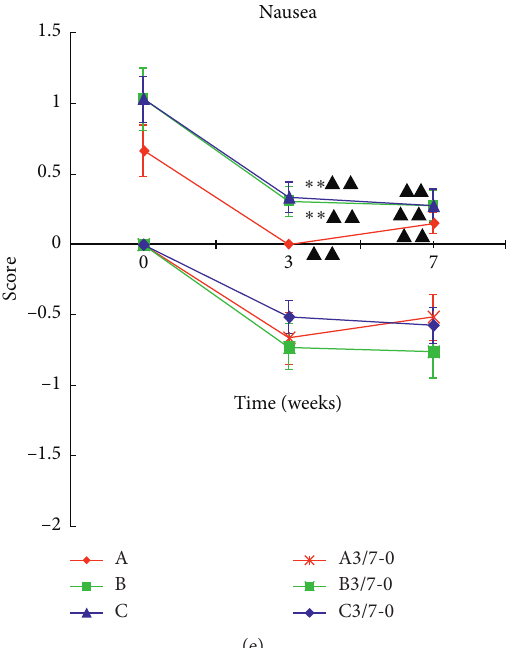
Figure 4: Comparison of five symptom scores in each group. 3-0 and 7-0 are the scores obtained by the 3rd and 7th weekend scores minus the 0th week. Data were expressed by mean ± M ( n � 33). ∗ P < 0 . 05, ∗∗ P < 0 . 01, compared with Zhongwan (CV 12) +Zusanli (ST 36) group; # P < 0 . 05, ## P < 0 . 01, Neiguan (PC 6)+Zusanli (ST 36) group comparison; ΔΔ P < 0 . 01, compared with the baseline